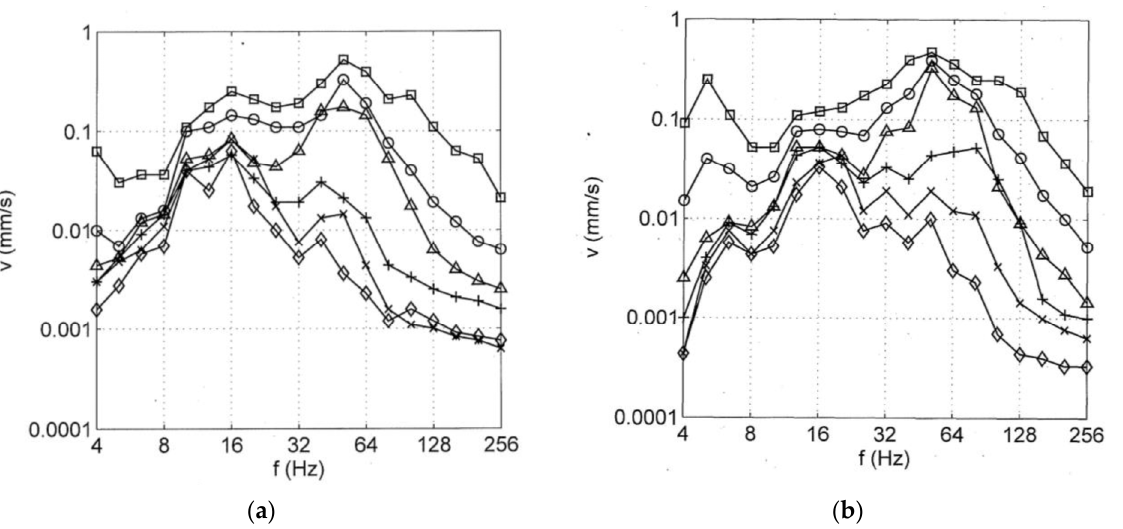
Figure 1. Train induced ground vibration, ( a ) at site N, ( b ) at site H, at distances x = □ 3, ○ 5, ∆ 10, + 20, × 30, and ◊ 50 m [20].